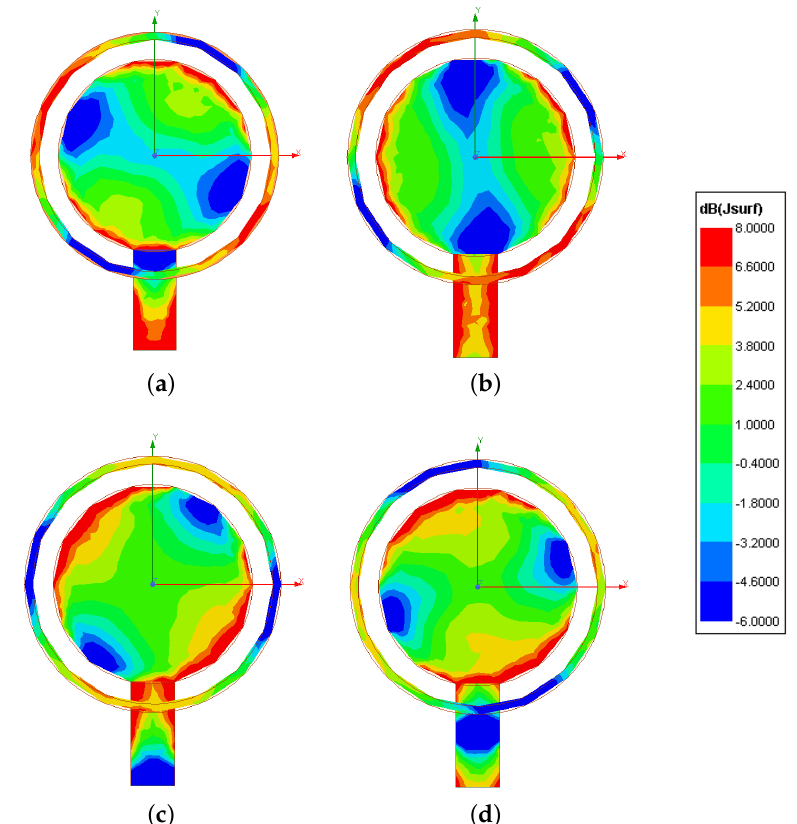
Figure 9. Numerical Assessment ( [ f min , f max ] = [ 2.3, 2.6 ] [GHz], f = f 0 = 2.45 [GHz])—Plot of the instantaneous surface current density magnitude, ( b ) t = T 0 [sec], ( c ) t = T 0 [sec], and ( d ) t = 3 8 4